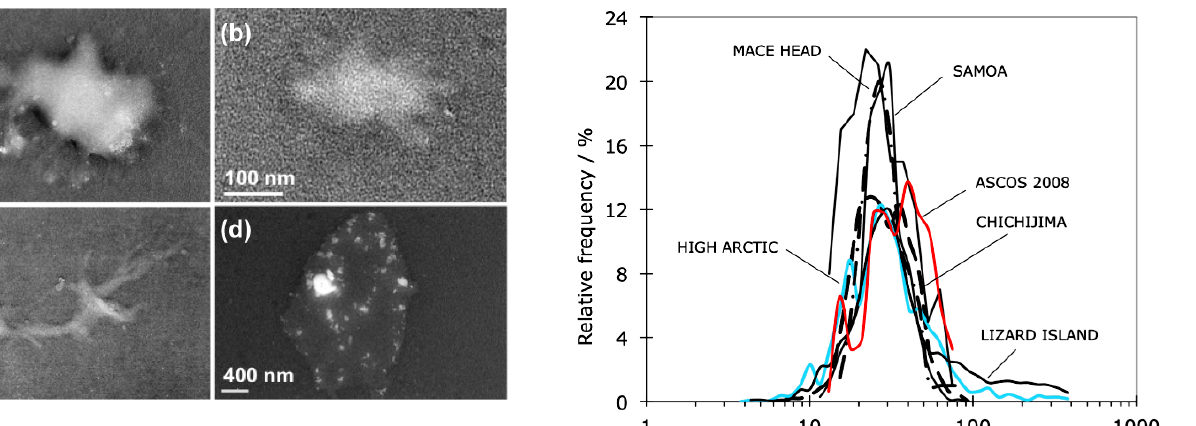
Figure 8. Examples for “mucus-like” particles observed with TEM: (a) mucus matter with small dense inclusions, partly outdrawn on the Formvar film; (b) mucus matter without dense inclusions; (c) mucus matter, extensively outdrawn on the Formvar film; (d) mucus matter with numerous small dense inclusions.